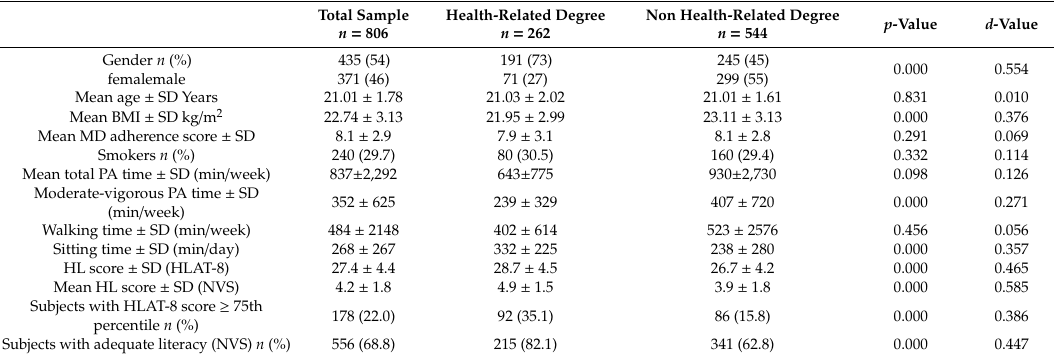
Table 1. Demographic characteristics and lifestyle of the study participants in the total sample and grouped for areas of study with related p and d